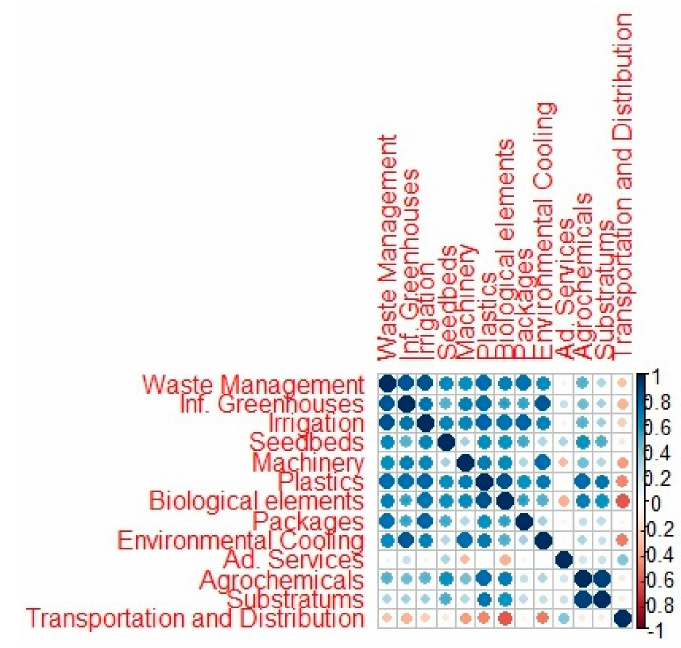
Figure A2. Correlation analysis of competing needs.